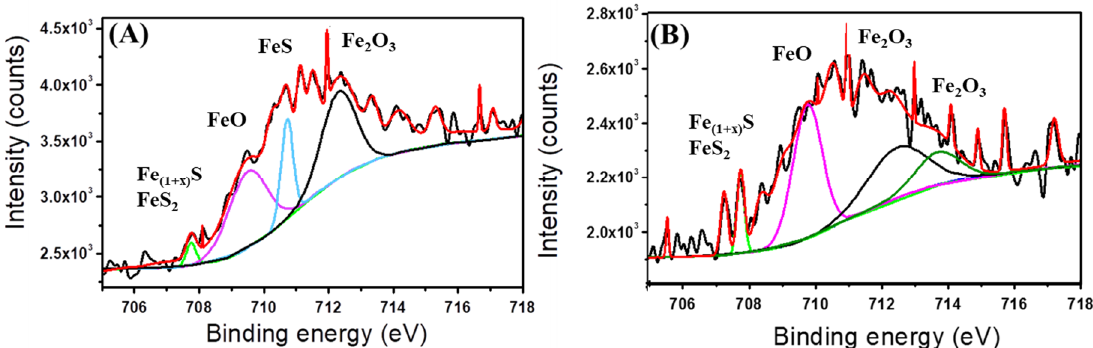
Figure 6. Fitted Fe 2p spectra from coupons incubated in SRB enriched media without CS/LS ( A ) and with 500 µg·mL −1 CS/LS ( B ) after 35 days of incubation. Fitted curves with different colour correspond to different chemical states; light green corresponds to FeS 2 and mackinawite (Fe 1 + x S), pink corresponds to FeO, Cyan corresponds to FeS, black and green correspond to Fe 2 O 3 .